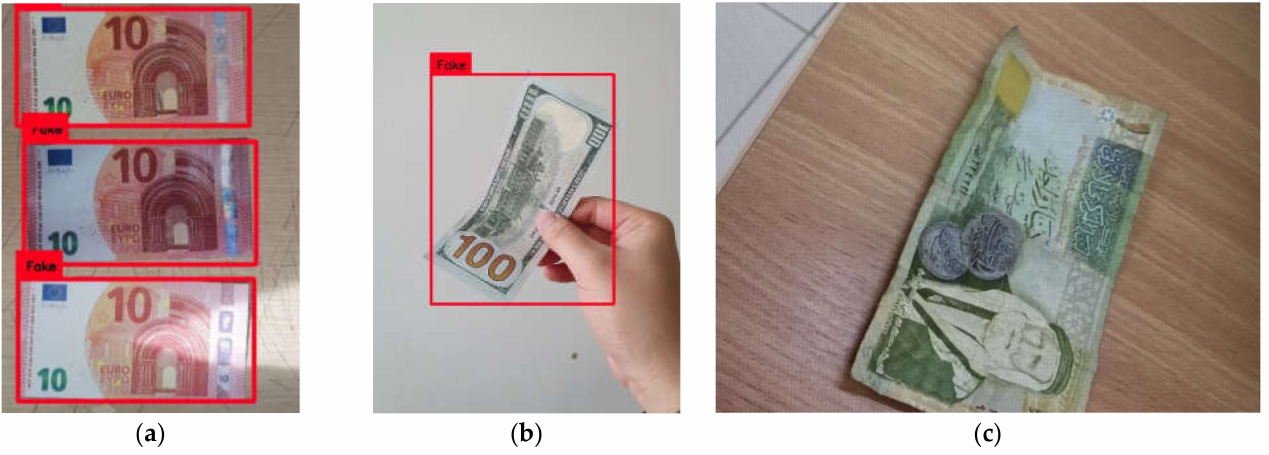
Figure 20. Error cases of ( a ) EUR, ( b ) USD, and ( c ) JOD banknote images using the models trained on the KRW dataset for